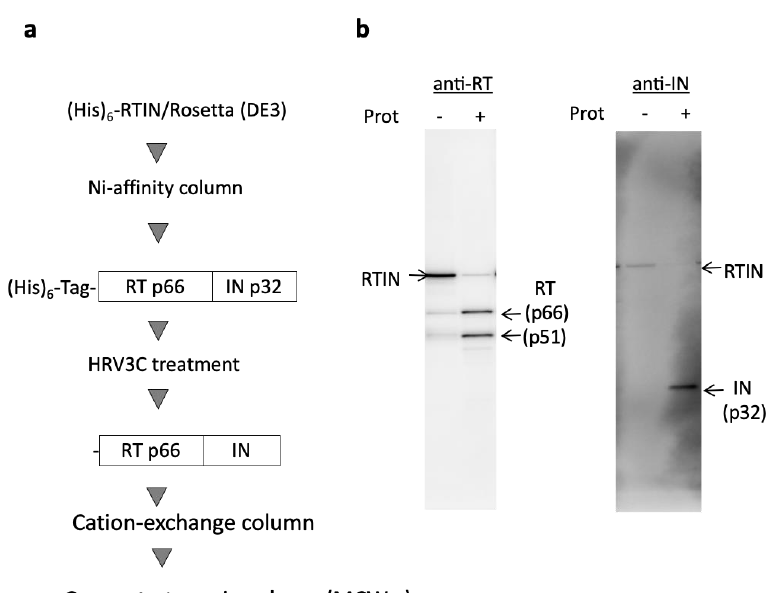
Figure 1. Preparation of recombinant HIV-1 RTIN protein. ( a ) (His) 6 -tagged form of HIV-1 RTIN was expressed in E. coli Rosetta (DE3) by incubation with 0.1 mM IPTG for 20 hrs at 18 °C. (His) 6 - tagged RTIN in the soluble fraction was purified through a Ni-affinity column. The (His) 6 -tag was then removed by treatment with HRV3C protease followed by glutathione-sepharose column chromatography to remove the HRV3C. The flow-through fraction was then subjected to cation exchange chromatography. Fractions eluted by 1xSP buffer [20 mM HEPES-NaOH (pH 7.0), 0.1 mM EDTA, 0.01% TritonX-100, 10% glycerol, and 1 mM DTT] containing 250 – 500 mM NaCl were pooled. The purified recombinant RTIN (rRTIN) was concentrated through a concentrator spin column with a filtration cutoff of 50 kDa (MCW 50 ) and stored in 1xSP buffer containing 300 mM NaCl at − 80 °C. ( b ). Purified rRTIN with (+) or without ( − ) HIV-1 protease treatment was subjected to Western blot analysis using an anti-RT (left) or anti-IN (right) antibody.